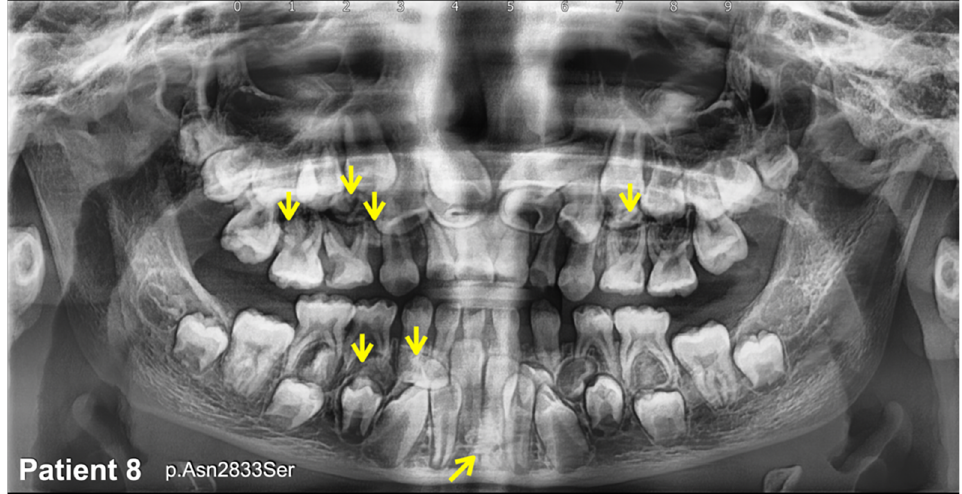
Figure 6. Patient 8. Panoramic radiograph showing multiple supernumerary teeth and multiple odontomas (arrows).